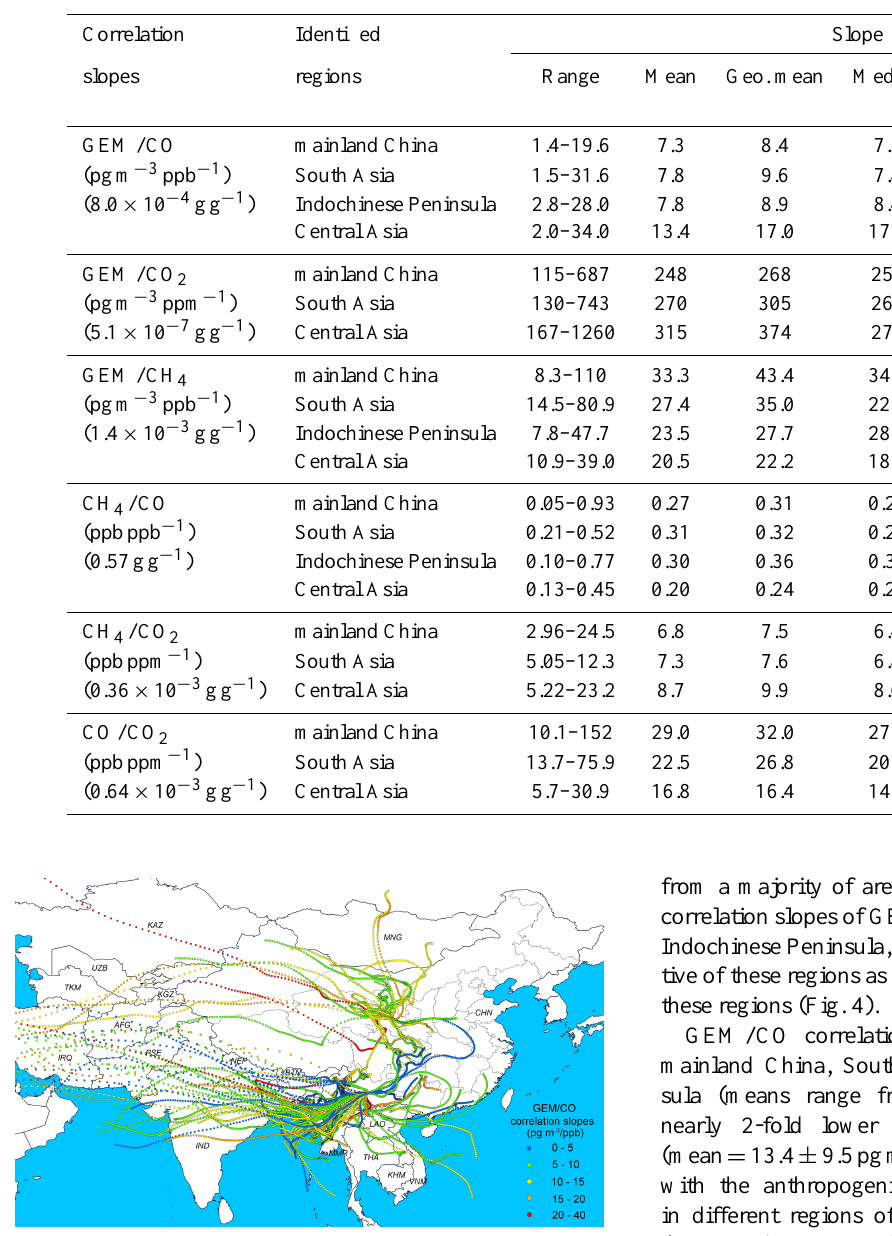
Table 1. Statistical summary of GEM/CO, GEM/CO 2 , GEM/CH 4 , CH 4 /CO, CH 4 /CO 2 , and CO/CO 2 correlation slopes observed for mainland China, South Asia, the Indochinese Peninsula, and Central Asia during the study period.